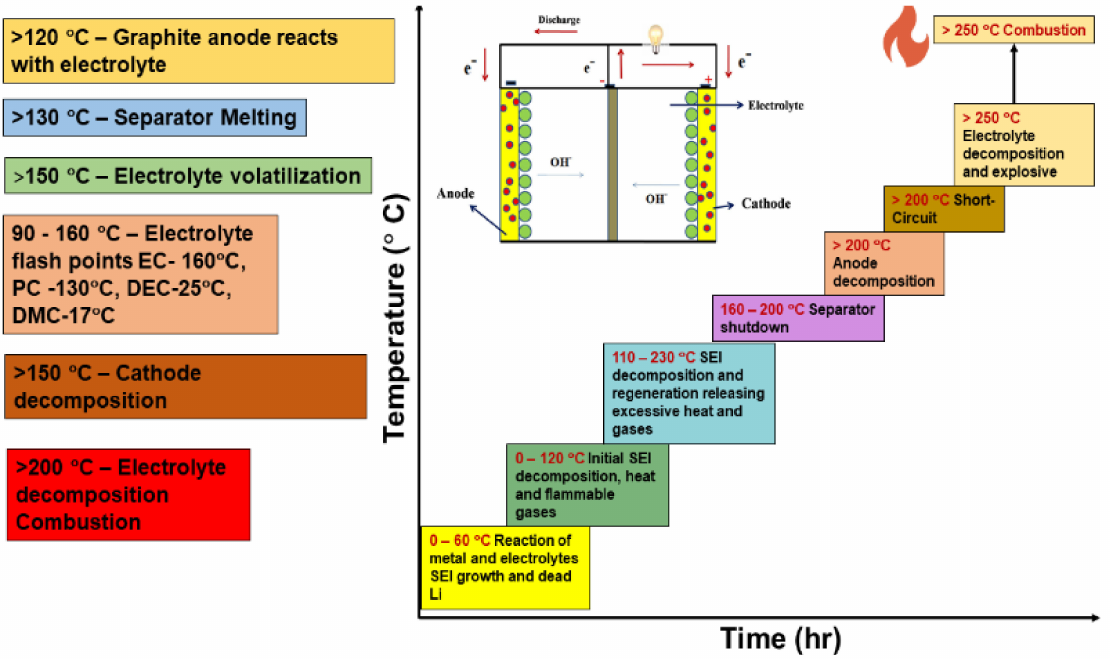
Figure 21. Hazards related to thermal instability due to dendrite